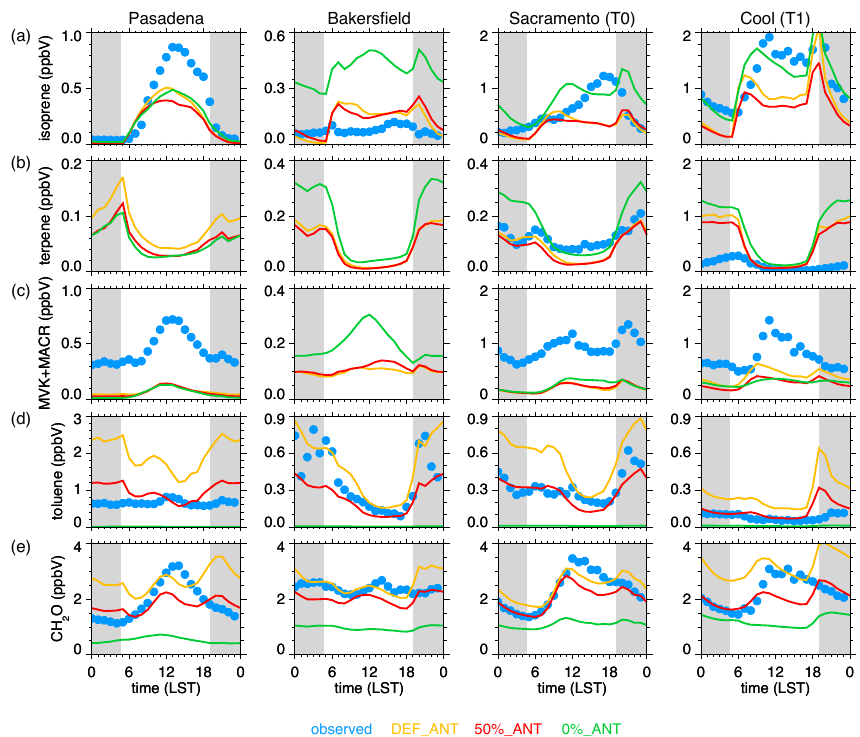
Figure 4. Observed and simulated diurnally averaged (a) isoprene, (b) terpene, (c) methyl-vinyl-ketone + methacrolein (MVK + MACR), (d) toluene, and (e) formaldehyde (CH 2 O) over the 2-month period at the Pasadena, Bakersfield, T0, and T1 supersites. Gray shading denotes night. Missing observations indicate measurements were not collected at a particular site. 50%_LBC simulation results not shown since they are nearly identical to those from the 50%_ANT